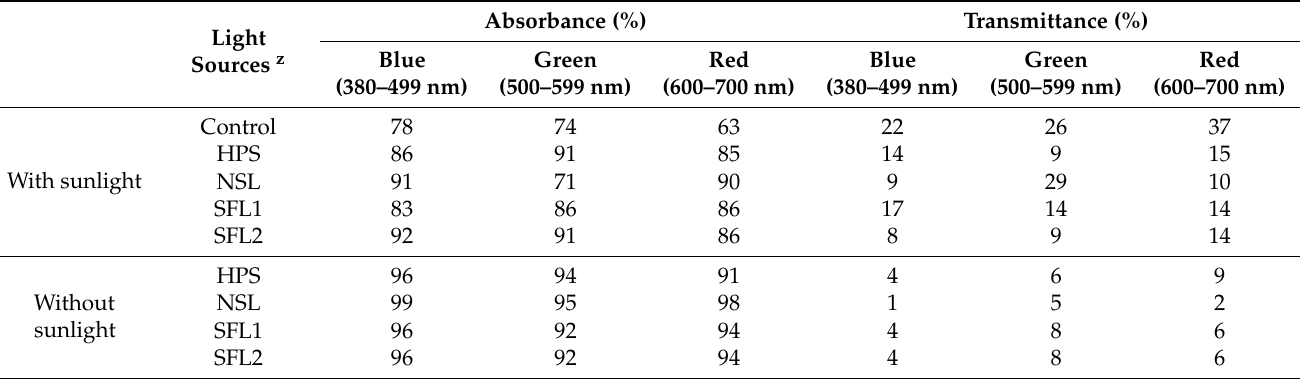
Table 3. Absorbance and transmittance of tomato plants grown in different SL sources after 7 weeks of treatment.